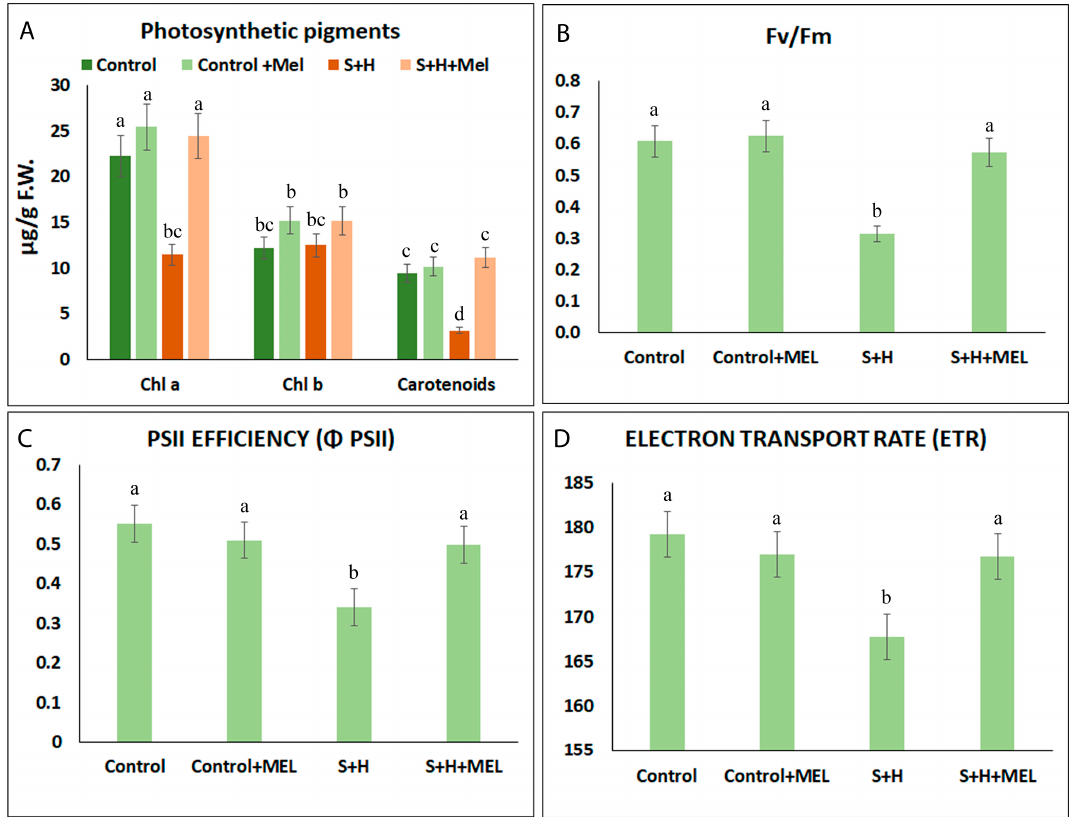
Figure 4. Photosynthetic pigments concentration (chlorophyll a, b and carotenoids) (A) and chlorophyll fluorescence-related parameters ( B – D ) in leaves of tomato plants grown under control or stress combination conditions (salinity + heat, S + H) with (+Mel) or without melatonin pre-treatment; ( B ) Maximum photochemical yield of PSII; ( C ) PSII Efficiency; ( D ) Electron transport rate. The figure is representative of four different measurements during the experiment. Values represent means ± SE ( n = 6). Bars with different letters within each panel are significantly different at p > 0.05 according to Tukey’s test.